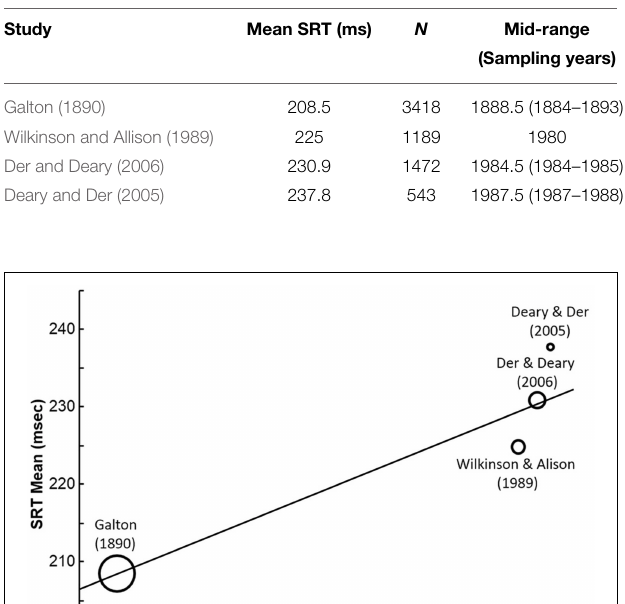
TABLE 1 | SRT means, sample sizes and sampling years for four large, age-matched UK samples.